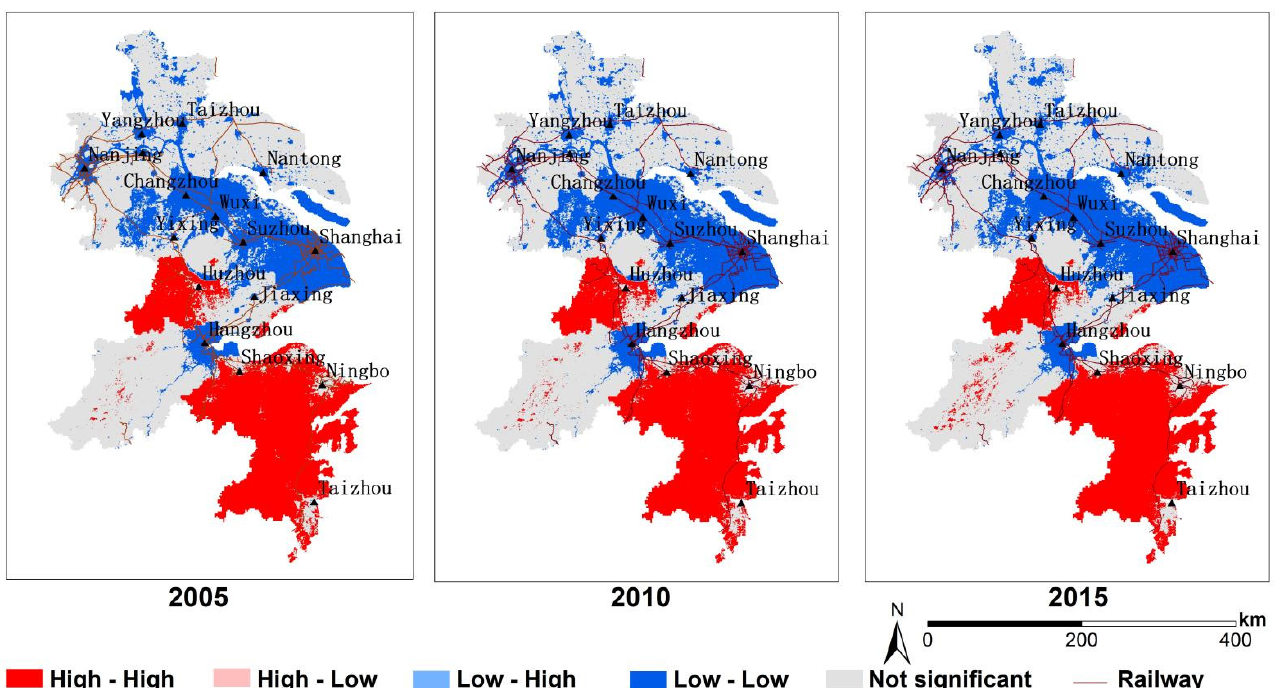
Figure 8. The Lisa clustering map of YDR in 2005, 2010, and 2015: (1) high ‐ high denotes spatial clustering of similar high values, (2) low ‐ low denotes spatial clustering of similar low values, (3) low ‐ high clustering denotes low values surrounded by high values, and (4) high ‐ low clustering de ‐ notes high values surrounded by low values.